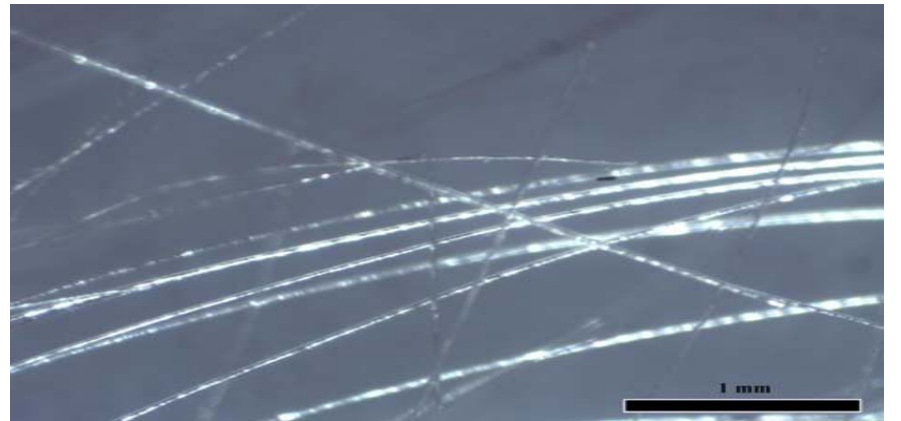
Figure 7 – External appearance of a conductive fiber from the BLU-114/B, magnified on a binocular microscope (size - 1 mm) (Serbian Armed Forces,